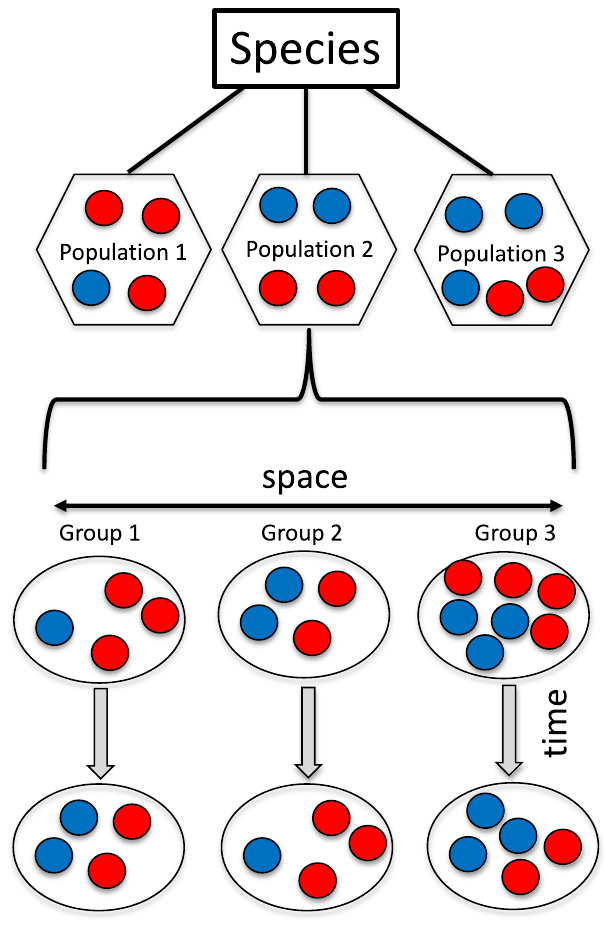
Fig. 5 Spatial and temporal variation in ASR. Every social group may have different number of adult females (red circles) and males (blue circles). A group ’ s ASR will change as a result of deaths, maturations, emigrations and immigrations over time, and neighboring groups of a population often have different ASRs. Adults may move between groups, and local ASR may trigger these movements 120,170 . The average ASR may vary across populations of the same species. This variation also raises the questions whether the current local or the average long-term population- or species- speci fi c ASR underly variation in social behavior and how animals perceive the relevant sex